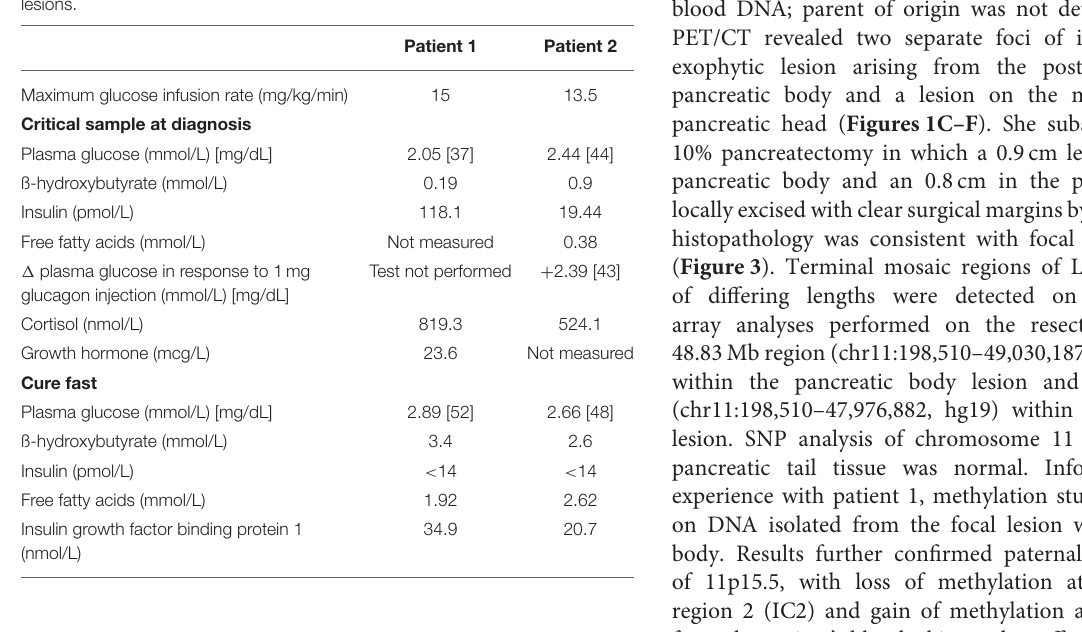
TABLE 1 | Biochemical evaluation at diagnosis and after surgical removal of the lesions.